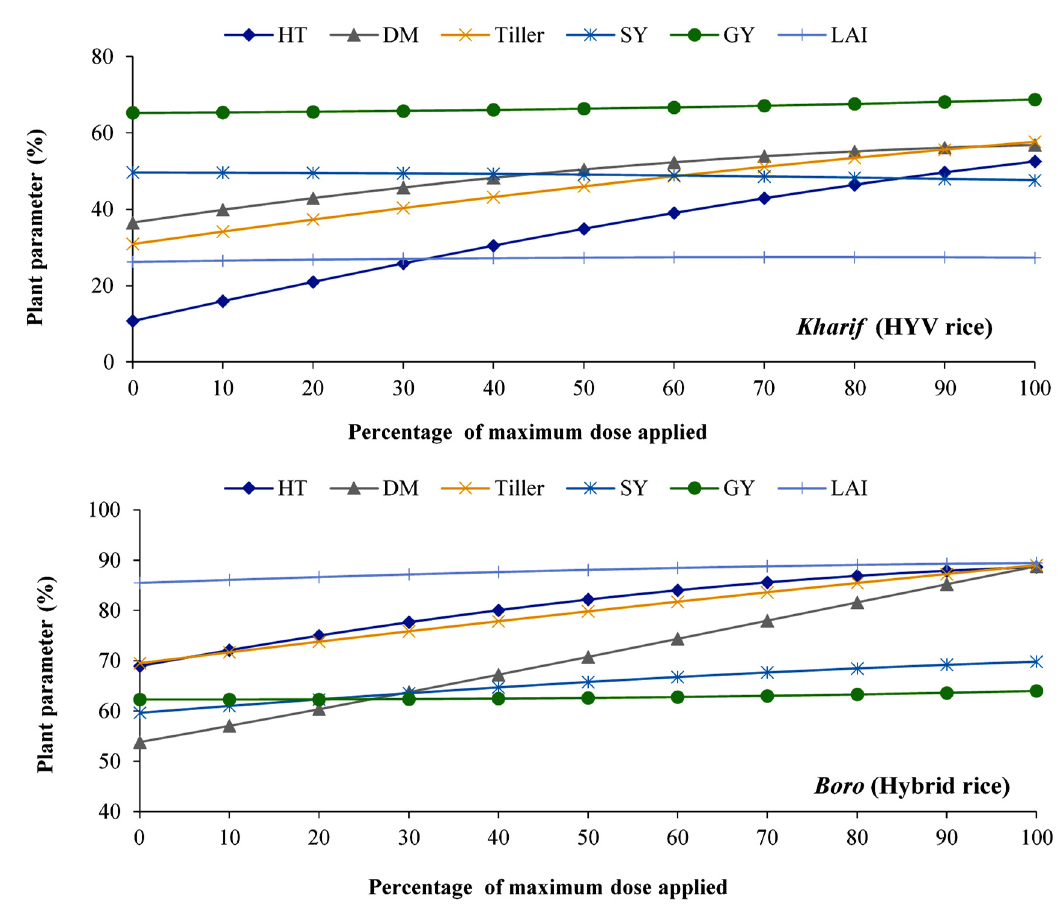
Figure 4. Effect of potassium on different plant parameters of kharif and boro season rice. For notation, see Figure 2.